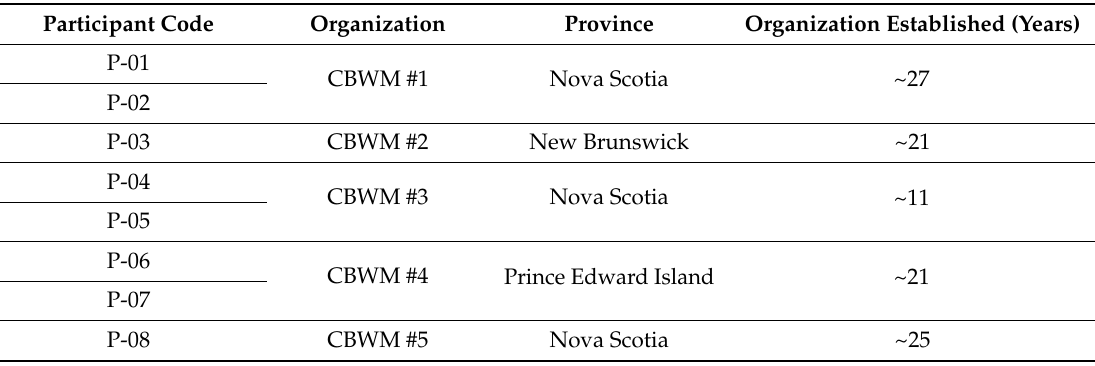
Table 1. Key Informant